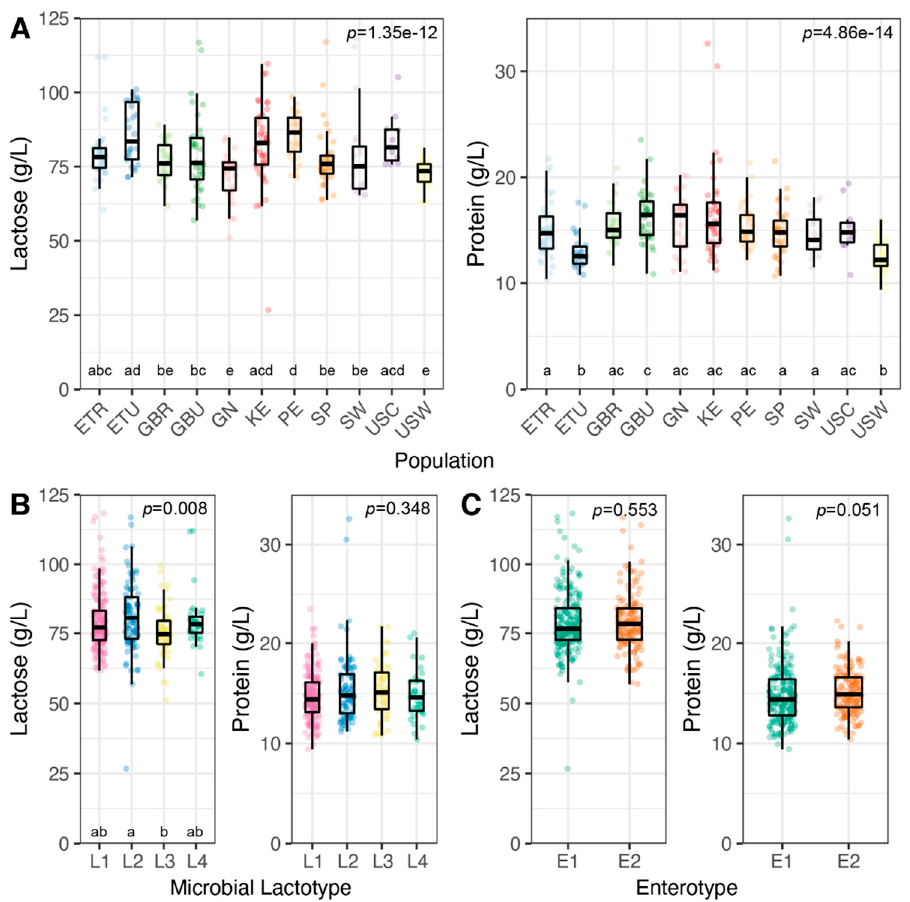
Figure 2. Concentrations of milk lactose and protein by population and community state type. Lactose and protein concentrations by ( A ) population of origin, ( B ) microbial lactotypes, and ( C ) en- terotypes. p Values were calculated from Kruskal–Wallis test (followed by Dunn’s post hoc test; letters above the group names along the x-axes denote significance groups, p <